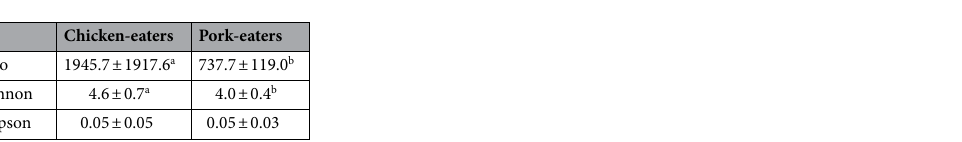
Figure 2. Chicken-eaters had higher diversity of the gut microbiota than pork-eaters. ( A ) Venn diagram of fecal microbiota at the OTU level. ( B ) PCoA plot of fecal microbiota at the OTU level. Each point represents one sample.